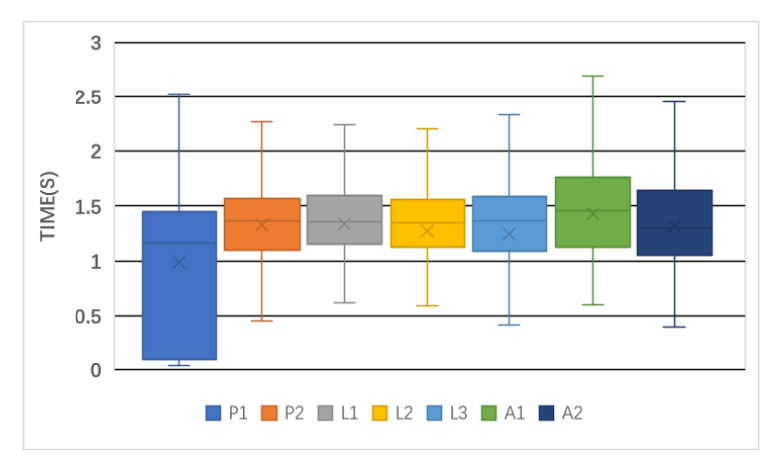
Figure 4. Real-time performance evaluation of the proposed